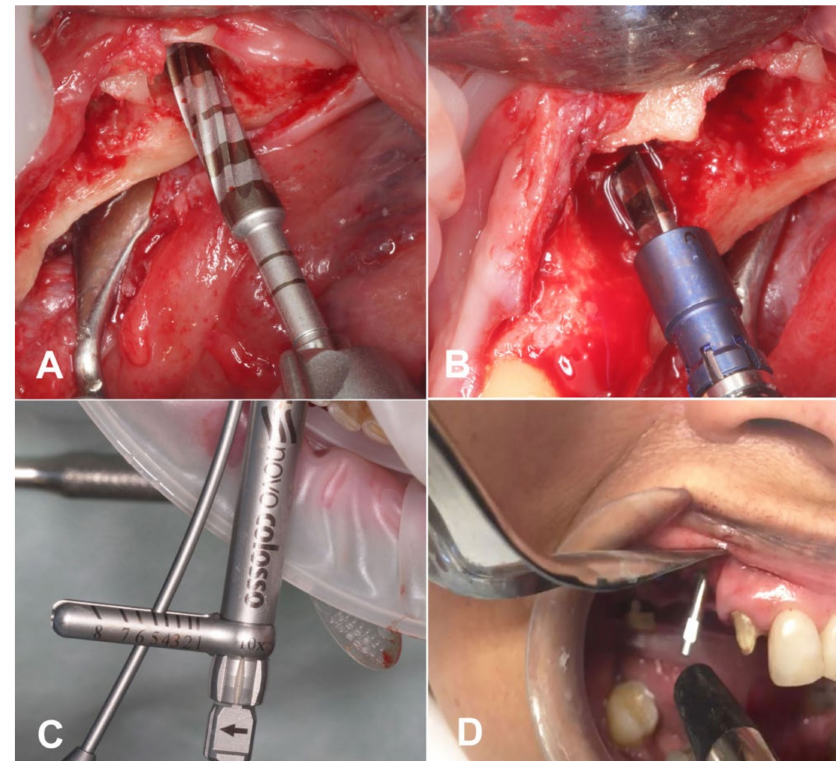
Figure 2. ( A ) Surgical procedure using osseodensification technique; ( B ) standard drill for undersized preparation; ( C ) clinical evaluation utilizing the torque wrench; ( D ) measurement of the stability quotient value using an implant Osstell ISQ device. Table 1. Drilling sequence, with respective diameter and manufacturer code, used to prepare the implant bed in each group. Drilling